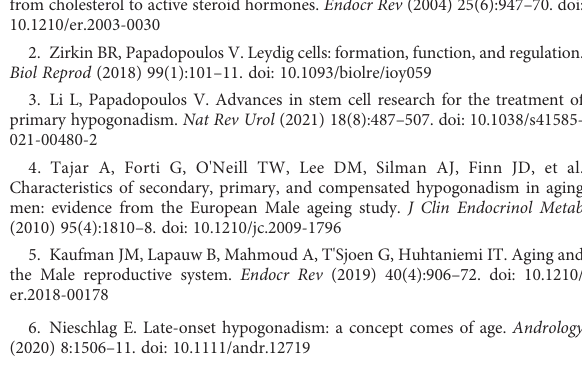
SUPPLEMENTARY FIGURE S1 Dose scan of TV159-172 infused subcutaneously. Sprague-Dawley rats were implanted with osmotic pumps delivering various concentrations of TV159-172 for 1 week. Levels of intratesticular testosterone (A) , serum testosterone (B) , dihydrotestosterone (C) , luteinizing hormone (D) , estradiol (E) , corticosterone (F) , and aldosterone (G) were measured in day 7 as described under material and methods. Data shown represent means ± standard deviation (N=5). SUPPLEMENTARY FIGURE S2 Modi fi cations to the RVTQ core increase plasma testosterone levels after oral administration. A) Testosterone levels in Brown-Norway rats 3 hrs after gavage with RVTQ and indicated RVTQ derivatives used at the indicated concentrations. Age of Brown-Norway rats during experiment was 60-123 days-old; N = 7; results shown as mean ± SD; *p<0.05; T denotes the order with which the peptides were